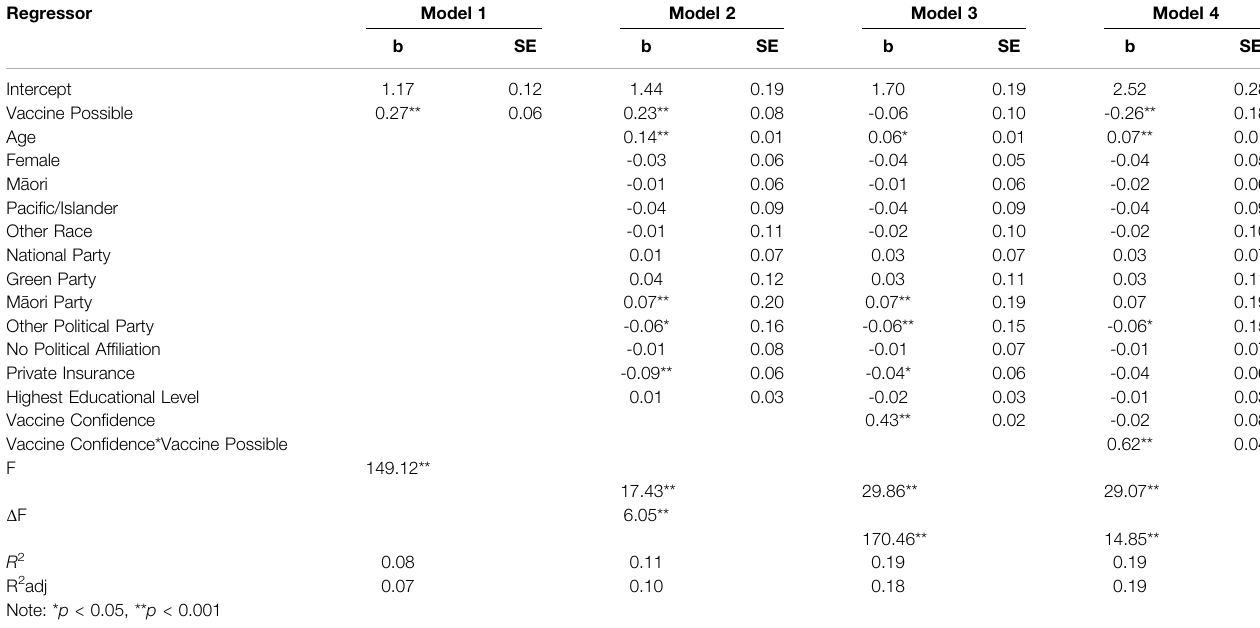
TABLE 3 | Regression Model for Support for Termination of Employees. Regressor